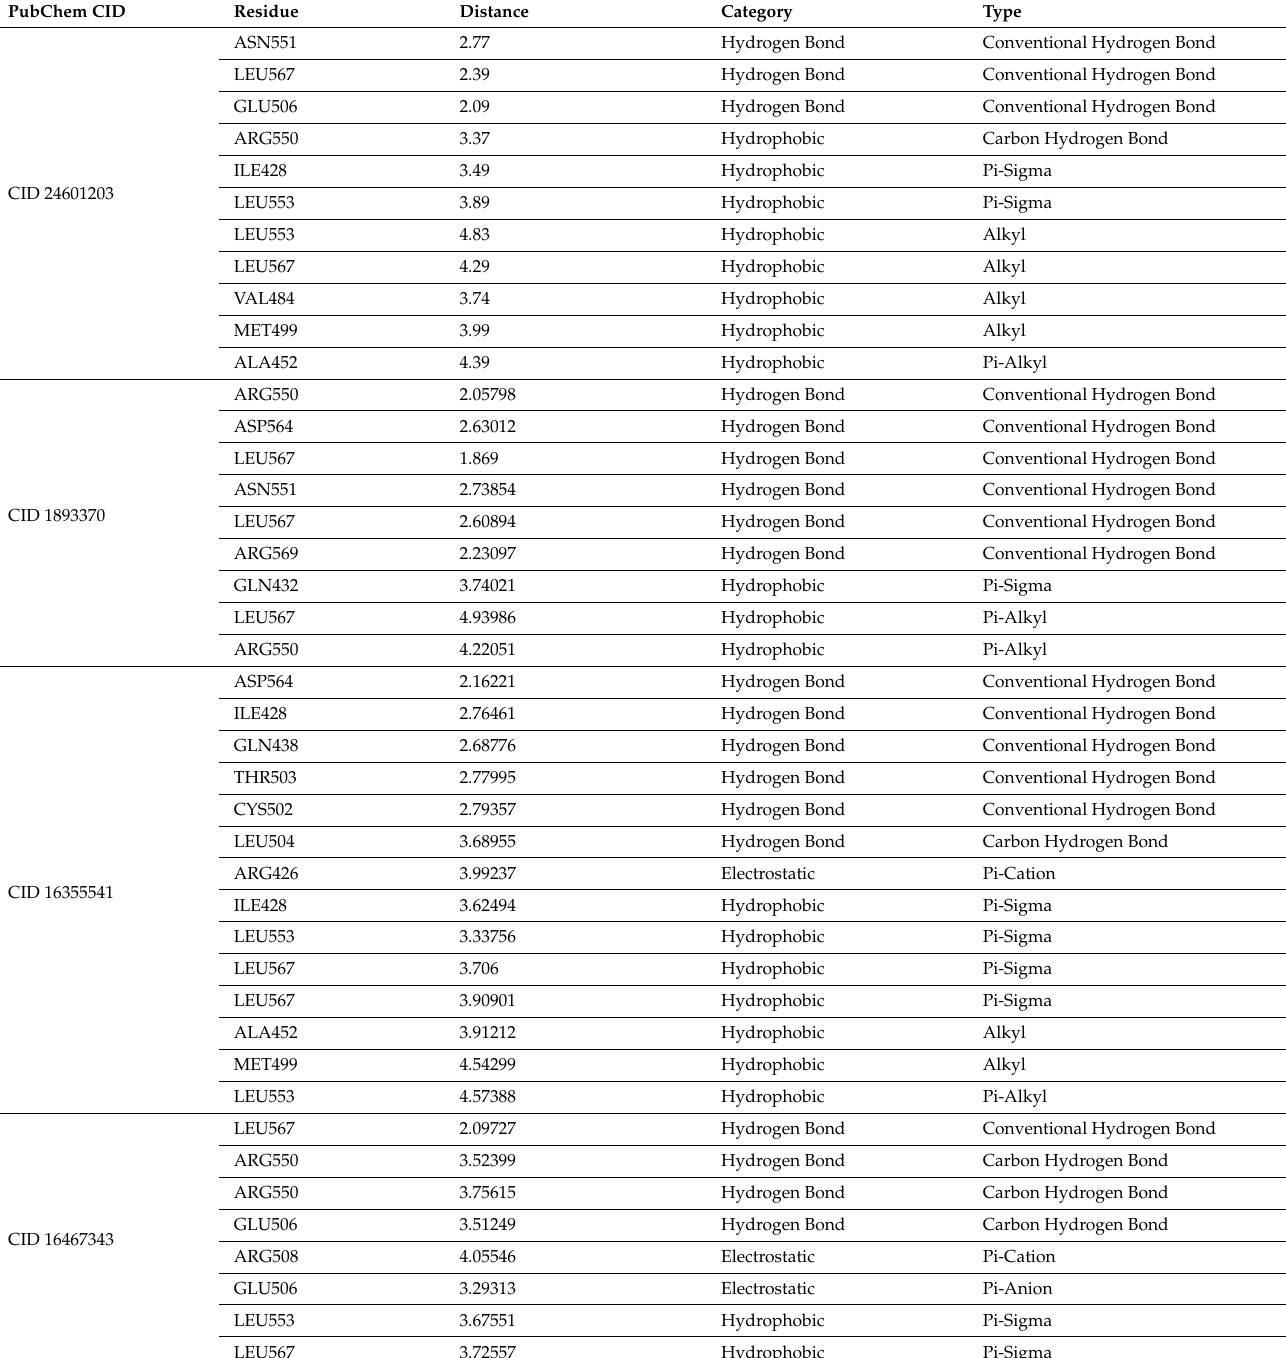
Table 3. List of bonding interactions between selected four compounds with FAK1